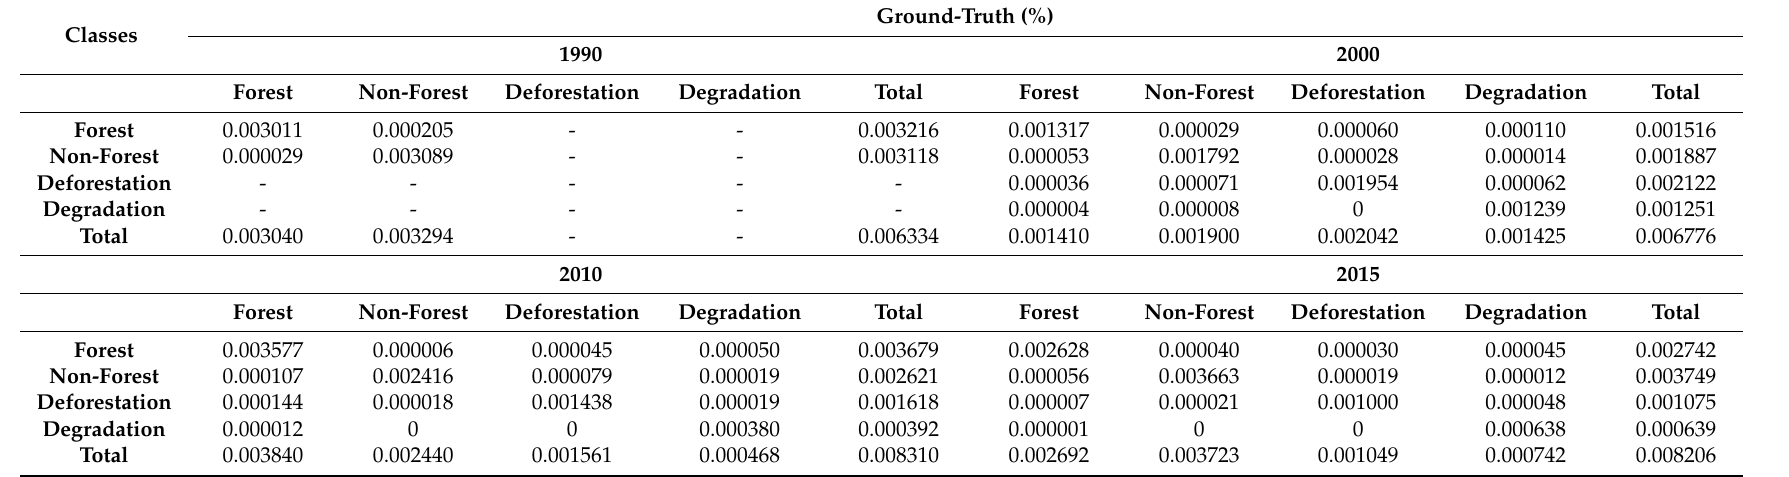
Table 1. Error matrix in terms of estimated proportions of area for each map